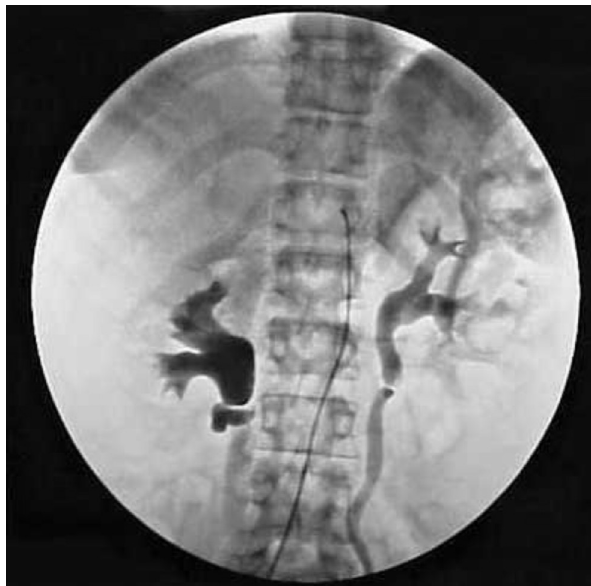
Figure 3 - Delayed arteriography phase showing hydronephrosis on the right pyelocaliceal renal